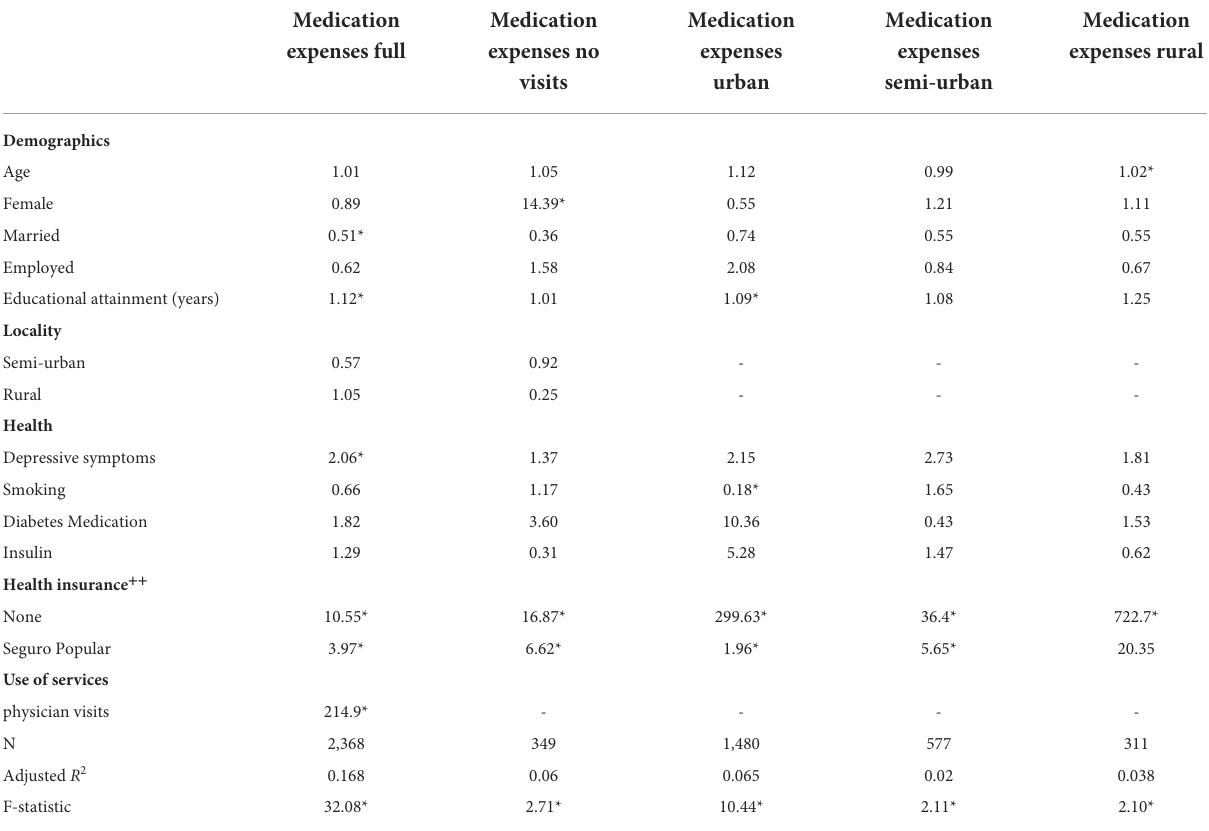
TABLE 2 Average effects of out-of-pocket medication